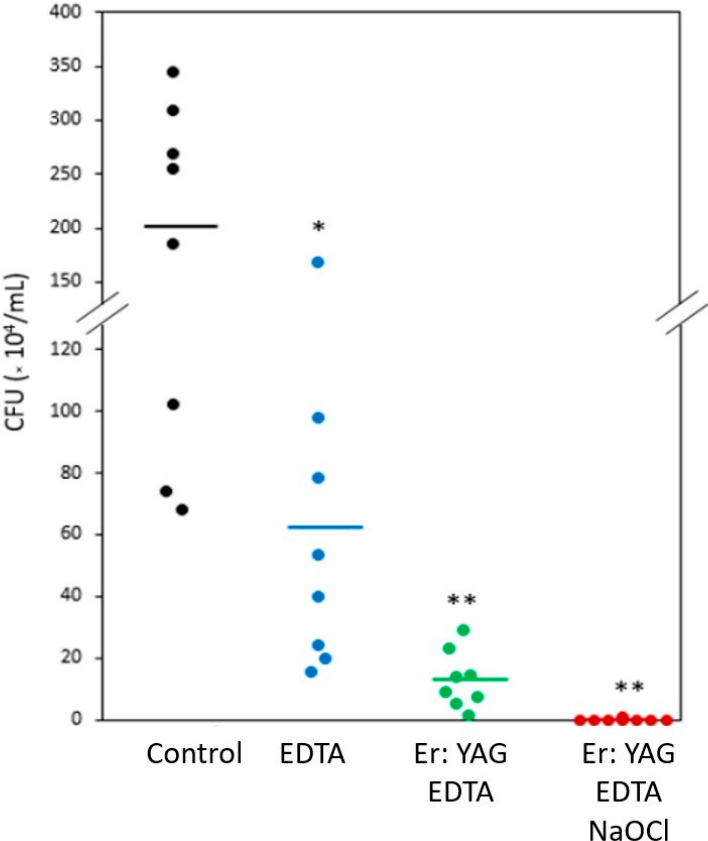
Figure 3. The number of E. faecalis colonies after treatment of infected teeth was compared between control (untreated infected root canals) and 3 groups of 17% EDTA irrigation: Group 1: The CFU of control samples infected with E. faecalis without receiving any treatment (black). Group 6: The CFU of E. faecalis in the root canals after a 17% EDTA irrigation (blue). Group 3: The CFU of E. faecalis after using an Er:YAG laser-Endo tip and a 17% EDTA irrigation (green). Group 8: The CFU of E. faecalis after using an Er:YAG laser-Endo tip and a 17% EDTA irrigation, followed by a 2.5% NaOCl irrigation (red). N = 8 in each group. * p < 0.01 for treated samples compared to control. ** p < 0.001 for treated samples compared to control. p < 0.02 for EDTA versus ER:YAG laser with EDTA. p < 0.001 for ER:YAG laser with EDTA and ER:YAG laser with EDTA and